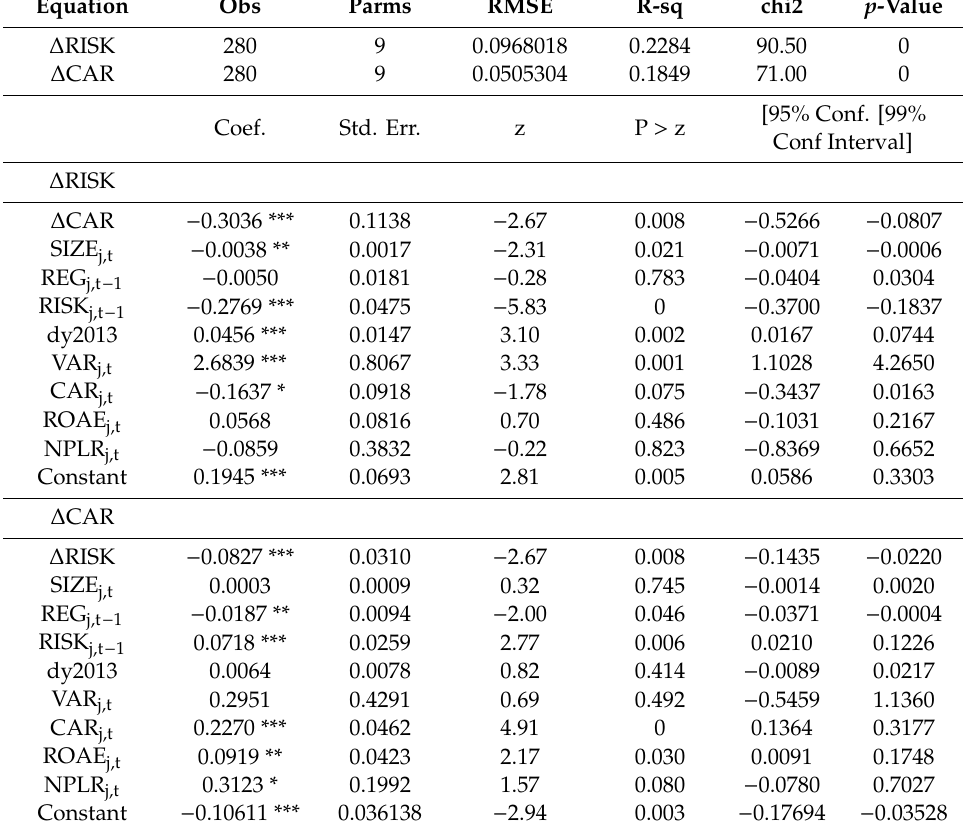
Table 4. Three-stage least-squares regression on the simultaneous equations